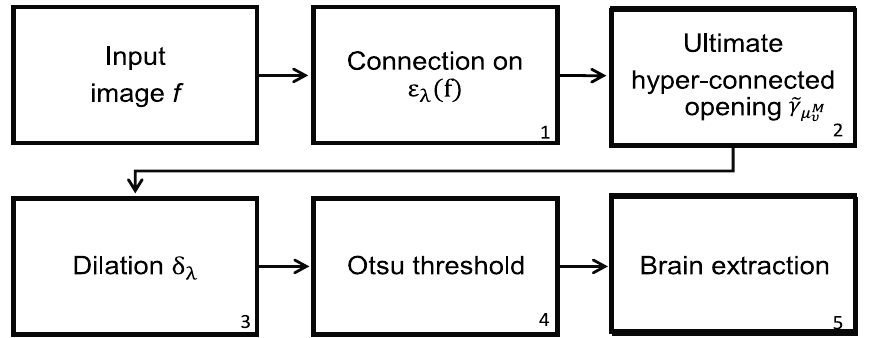
Figure 8. Steps to segment the brain using the maximum hyperconected function (MHF), denoted as the MHF